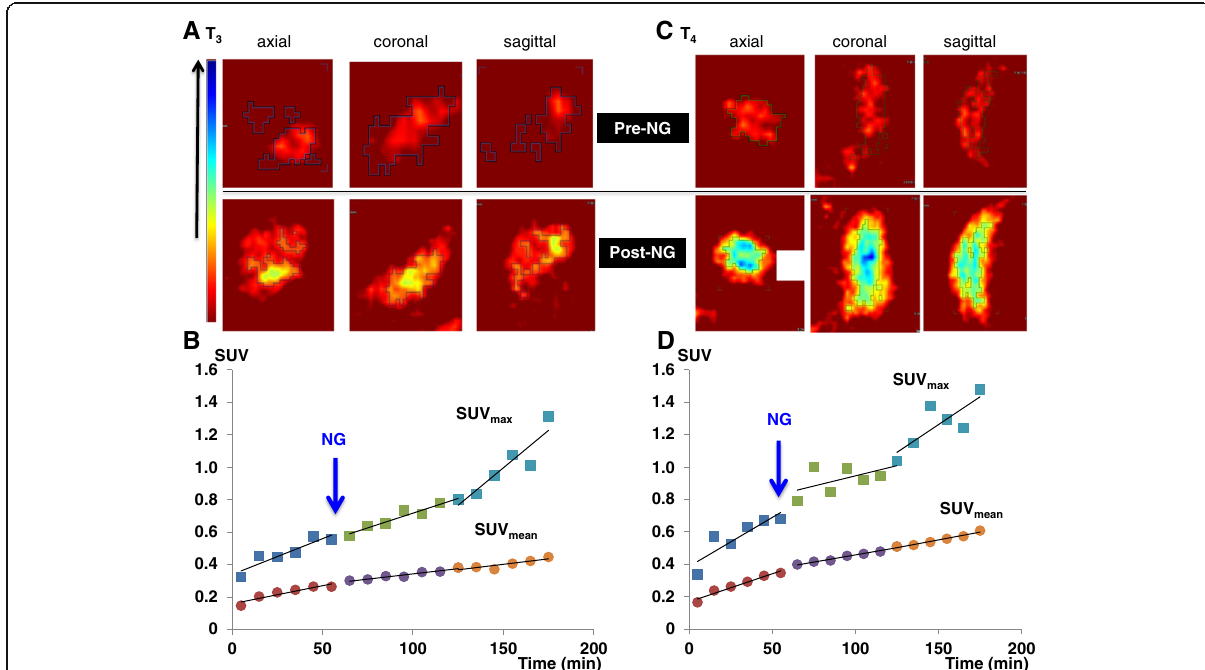
Fig. 5 Nitroglycerin (NG) effect on the uptake of albumin-bound [ 68 Ga]ABY-028 in A431 xenografts. a , c Axial, coronal, and sagittal PET images of a T 3 and c T 4 . Upper row (pre-NG) images are summed over 0 – 60 min following the tracer injection, lower row (post-NG) images are summed over 120-180 min. All images use the same scale of SUVs shown in the color bar to the left. b , d Mean and maximum SUV TACs in T 3 and T 4 , respectively, for 60 min prior to and 120 min after topical application of NG show that NG-induced changes are revealed by the SUV